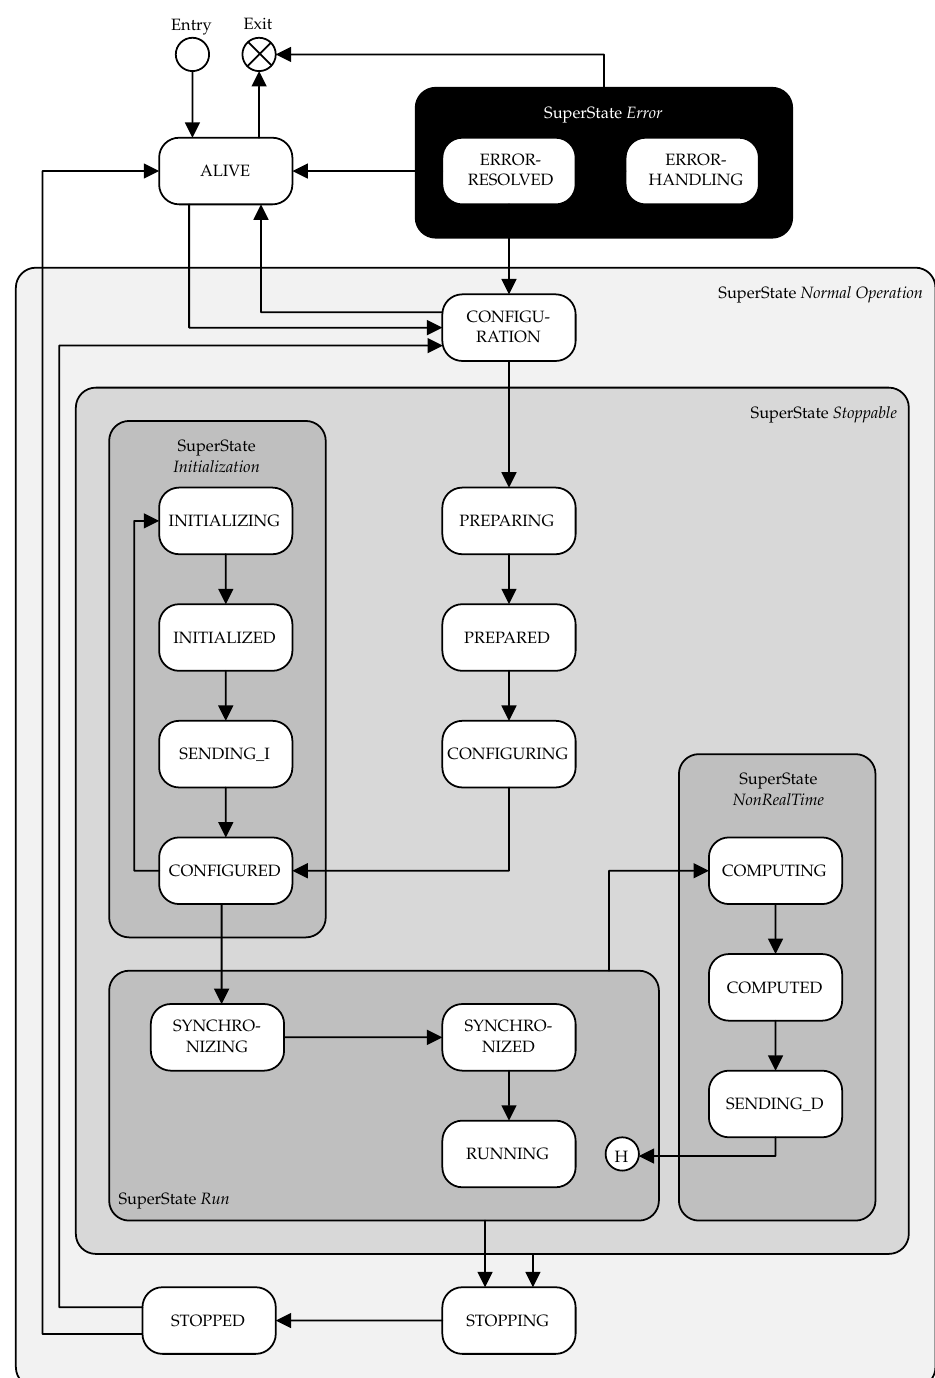
Figure 6. Standard DCP slave state machine implementation, based on the Ref.